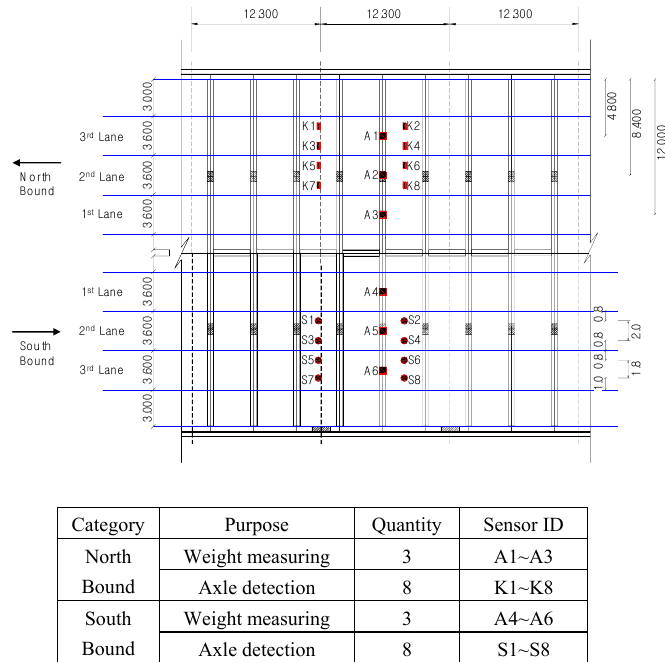
Figure 4. Sensor disposition of Seohae Bridge (unit: m).